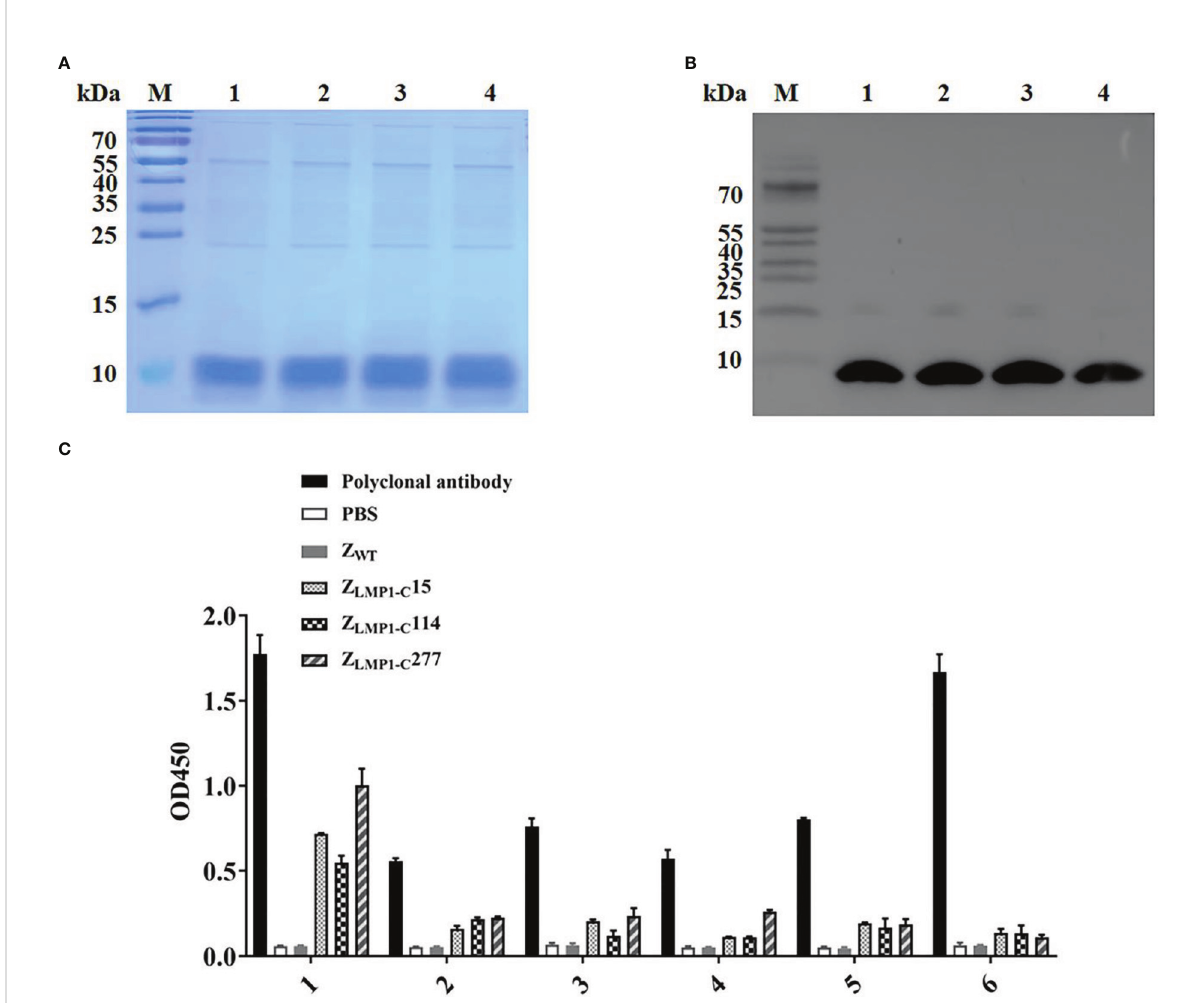
FIGURE 1 Analysis of binding of Z LMP1-C to recombinant LMP1-C. The puri fi ed Z LMP1- C af fi body molecules were used for SDS-PAGE analysis (A) and con fi rmed by Western blotting (B) M, protein marker; 1, Z LMP1-C 15; 2, Z LMP1-C 114; 3, Z LMP1-C 277; 4, Z WT . (C) Epitope mapping of the Z LMP1-C af fi body molecules by ELISA. The truncated peptides (1-6) derived from LMP1-C were designed and synthesized. Both Z LMP1-C and polyclonal antibody reacted with the LMP1-C peptides. In sequence, red font indicates the binding region recognized by Z LMP1-C af fi body molecules (Table 1). The error bars represent the standard deviation.